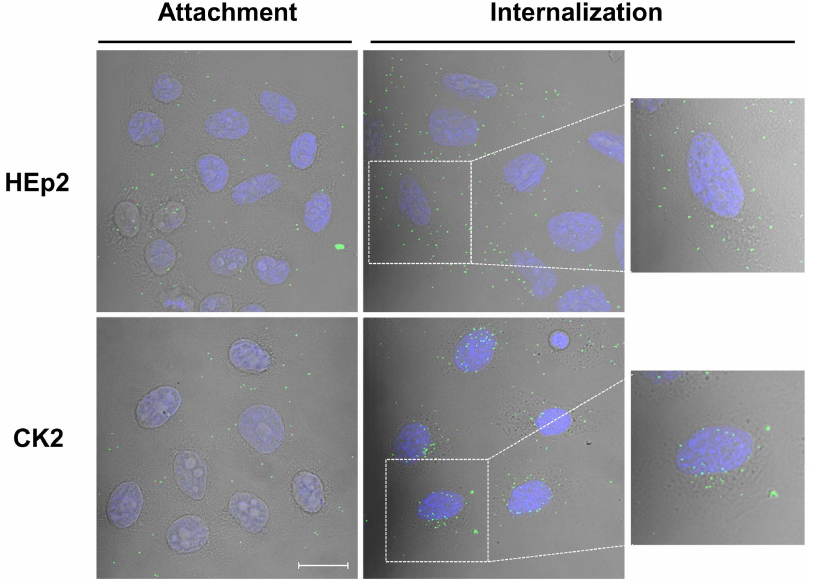
Figure 6. RhoB influences Ad5wt intracellular trafficking. Confocal microscopy of attachment and internalization of fluorescently labeled Ad5wt at MOI 4 6 10 4 pp/cell in HEp2 and CK2 cells. Cells were incubated with Alexa Fluor 488-labeled virions for 60 minutes on ice. Unbound virus was removed and cells were either fixed to measure attachment or fed with fresh medium and incubated at 37 u C for 30 minutes before fixation to allow virus internalization. Overlay of virus (green), nucleus stained with DRAQ5 (blue) and phase-contrast is shown. Scale bar presents 20 m